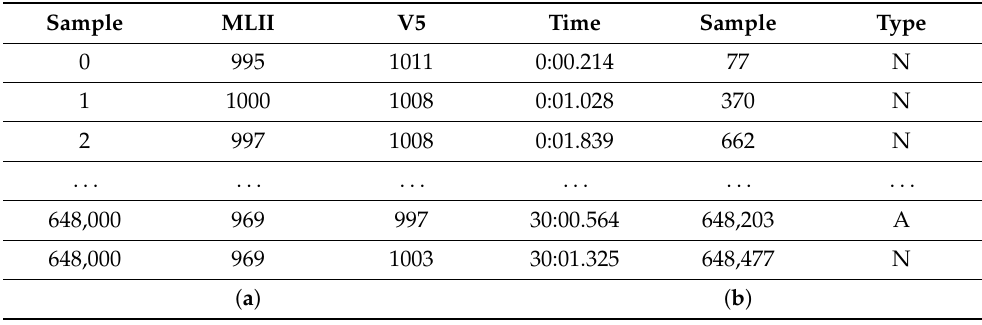
Table 1. Example of one 30-min ECG recording digitized at 360 samples per second provided by Kaggle. ( a ) Each row is a sample of Modified-Lead II MLII and V5 lead signals quantized with 11-bit resolution over a ± 5 mV range. Sample values thus range from 0 to 2047 inclusive, with a value of 1024 corresponding to zero volts; ( b ) only includes annotated samples f(N = normal or A = anomalous) with a timestamp.